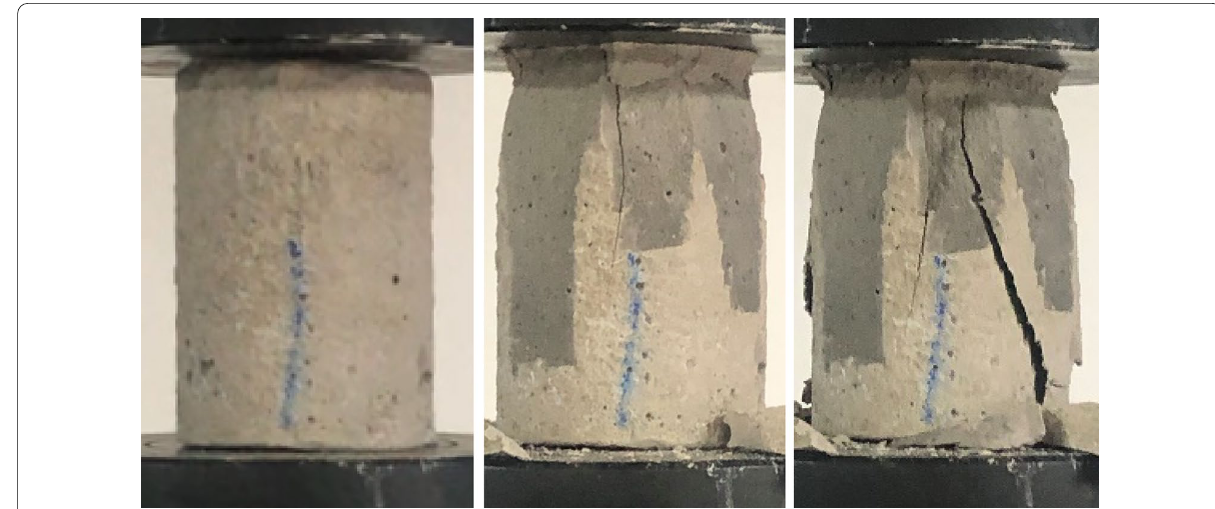
Fig. 12 Morphology of the sample before and after loading.